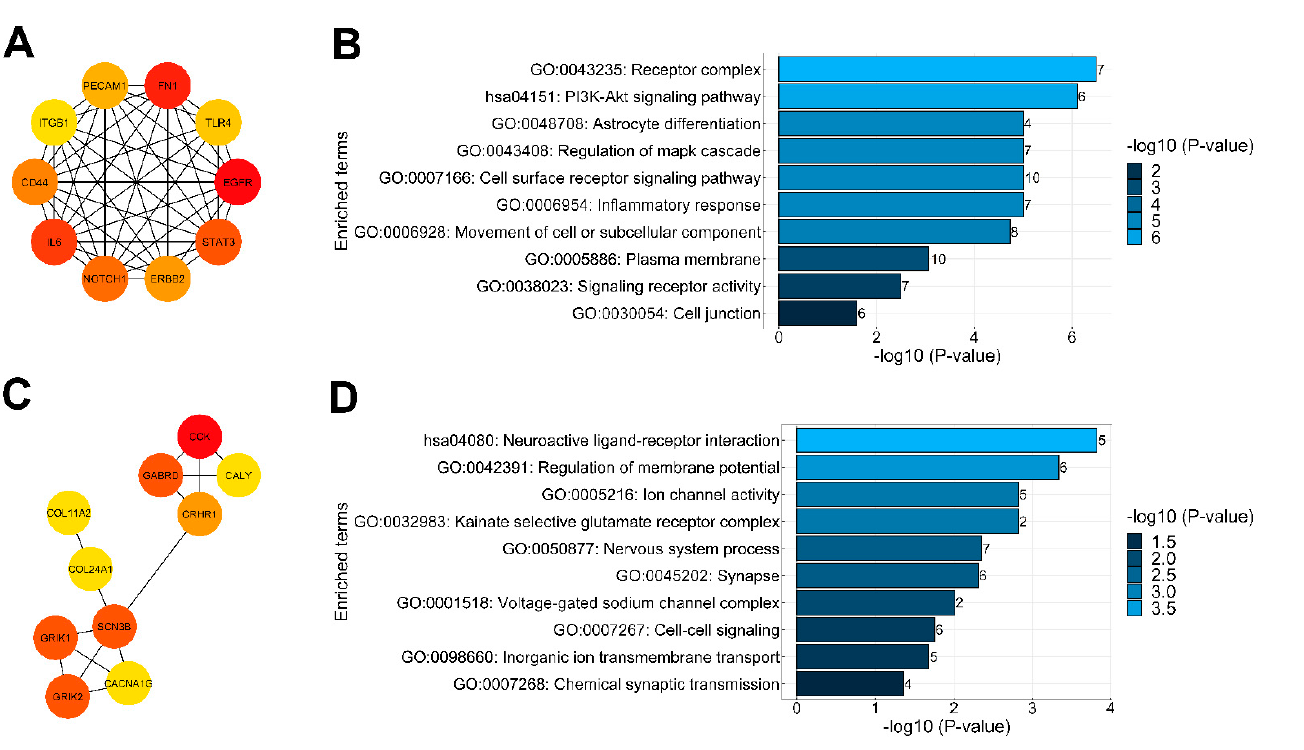
Figure 4. The top 10 down- and upregulated DEGs of PPI network. ( A , C ) The top 10 ranked DEGs of PPI networks were obtained from CytoHubba analysis based on the degree method. ( A ) The panel shows the top 10 DEGs of downregulated genes and ( C ) represents the top 10 DEGs of upregulated genes. The change in color from red to yellow represents a change in the degree score from high to low. ( B , D ) Gene Ontology (GO) functional and KEGG pathway classification of top 10 DEGs analyzed through stringApp with the FDR-corrected p -value < 0.05. ( B ) The panel shows the enriched terms of top 10 downregulated DEGs, while ( D ) shows enriched terms of top 10 upregulated DEGs. On the graph, y-axis represents the significant enrichment terms. Each bar describes the number of mapped annotated genes in the reference data set while the x-axis and color gradient indicate the signi fi cance ( − log10 p -value) in each category.